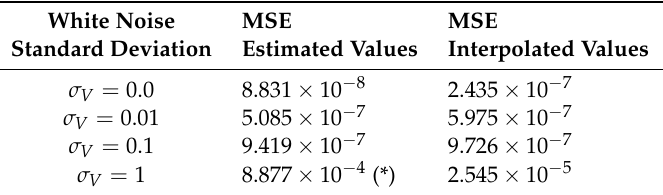
Figure 5. Results of the conductance estimation applied to a membrane potential generated from the noisy pyramidal cell model, but using the EIF model as a base model in the estimation procedure . Panel ( a ) shows the prescribed conductances (black curve) and the estimated conductances (red curve). Panel ( b ) shows the membrane potential (black curve) obtained from the noisy pyramidal cell model (3) with σ V = 0.1 and using the prescribed conductances of panel ( a ), and the reconstructed membrane potential (red curve) obtained also from the noisy pyramidal cell model but using the estimated conductances as input. Panel ( c ) shows the scatter plot of the prescribed conductances versus the estimated ones. The red line represents the identity line. Table 3. Errors caused by measurement noise. The first column shows different input noise levels. The second column shows the corresponding mean squared error obtained of the estimated conductance. The last column shows the mean squared error after the PCHIP interpolation of the estimated conductances. In these estimations, we have used the deterministic pyramidal cell model as the base model and a discretization of order δ g = 10 − 3 for the g syn . We have computed the mean errors over 100 realizations. (*) In this case, a few conductances have been overestimated and set to 0.1 to continue with the simulation.